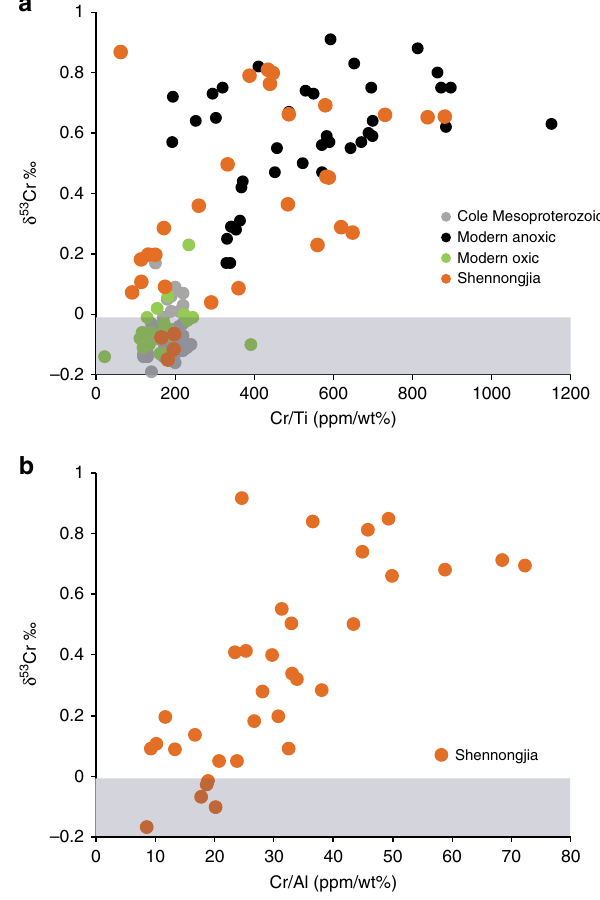
Fig. 6 The isotopic composition of chromium ( δ 53 Cr) compared to chromium enrichment. a Enrichment relative to Ti (Cr/Ti). Samples from the Shennongjia Group are given in orange circles, while modern sediments deposited in anoxic settings are given in black circles and modern oxic settings are given in green circles. Mesoproterozoic-aged shales from ref. 30 are given in gray circles. b Enrichment relative to Al (Cr/Al) for samples of the Shennongjia Group. Cr/Al data are not available for other modern and ancient sediments. The shaded horizontal bar represents the δ 53 Cr range for crustal values 39 . All data and references are summarized in Supplementary Table 3